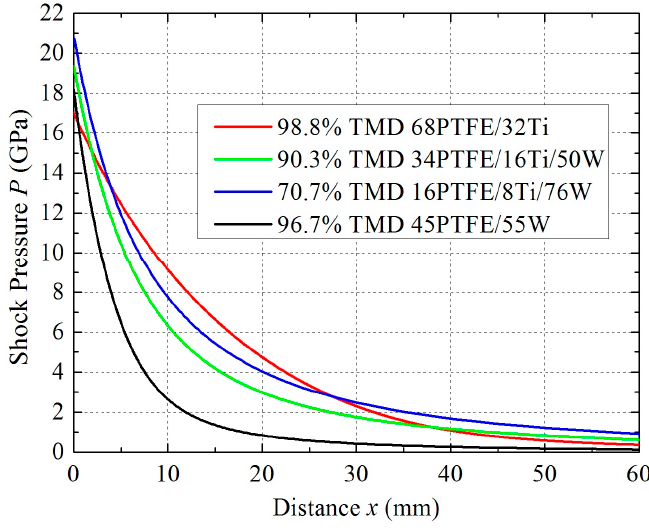
Figure 12. Pressure–distance curves for shock wave propagation.